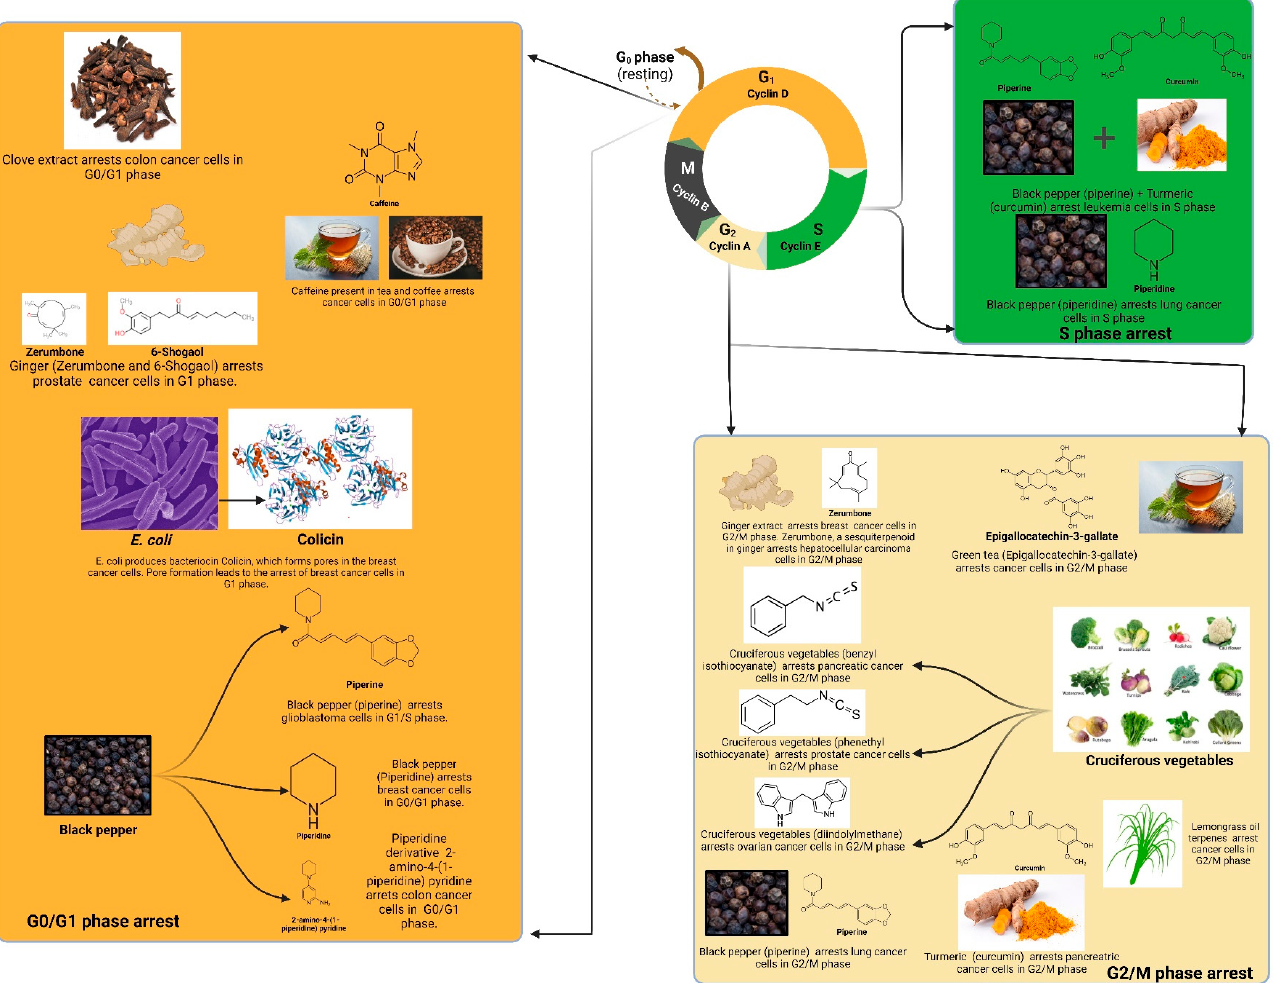
Figure 2. Various bioactive food components cause cell-cycle arrest at G0/G1, G2/M, and S phases in cancer cells. (Figure created with Biorender.com).